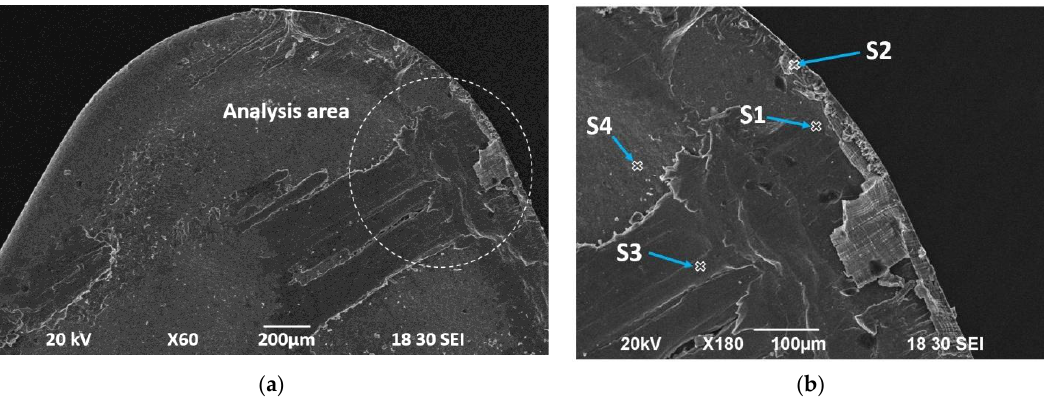
Figure 12. Tool rake face SEM image for v c = 40 m/min, f = 0.05 mm/rev, R4; ( a ) analysis area; ( b ) spectrums (analyzed